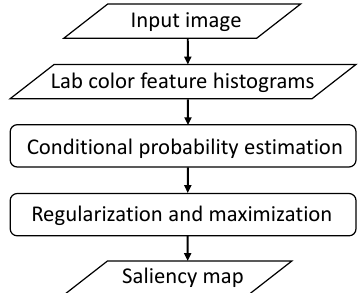
Figure 5. Flowchart of the SEG saliency model.